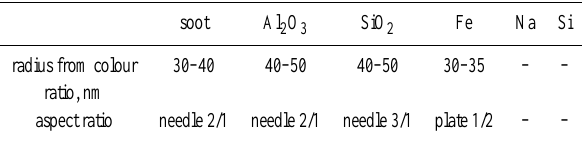
Table 3. Particle radii and aspect ratios matching the observations at ALOMAR on 22 and 24 November 2000. Mode-width is σ = 1 . 4 soot Al 2 O 3 SiO 2